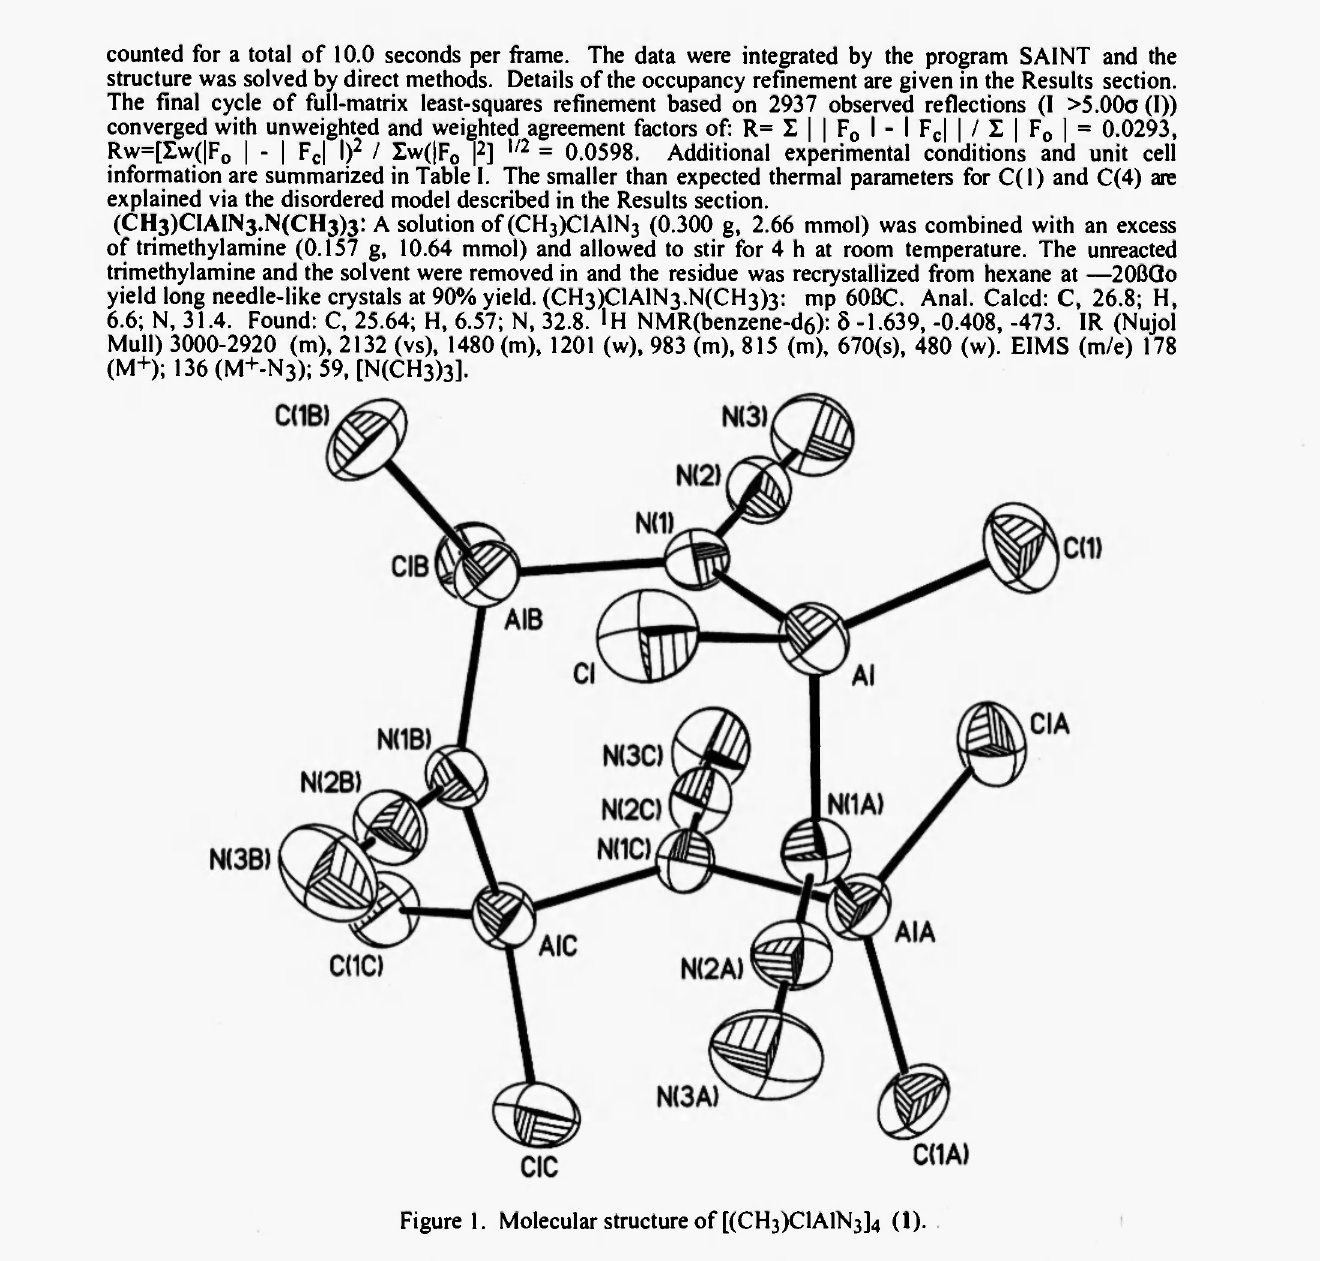
Figure 1. Molecular structure of [(CH 3 )C1A1N 3 ] 4